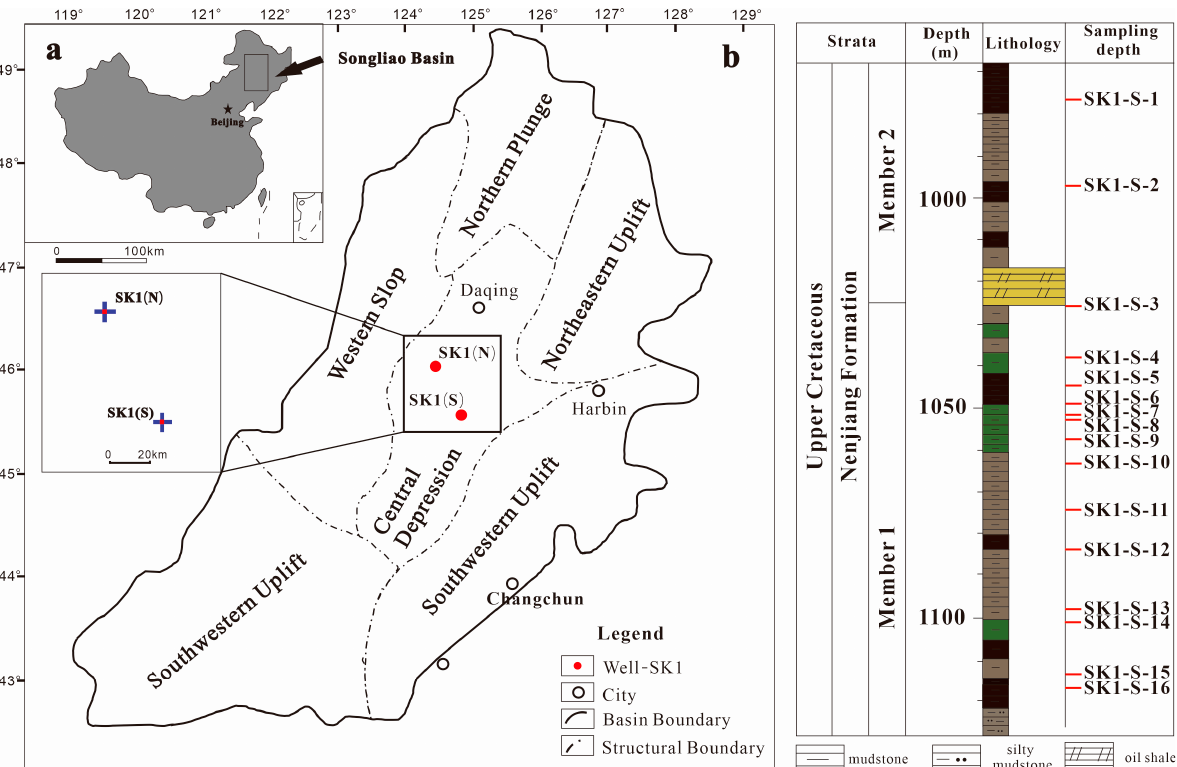
Figure 1. ( left ): ( a ) Location of the Songliao Basin in China; ( b ) the main structural divisions of Songliao Basin and drilling sites of SK-1(S) and SK-1(N). ( right ): Lithology and sampling depth of K 2 n 1+2 in SK-1(S).